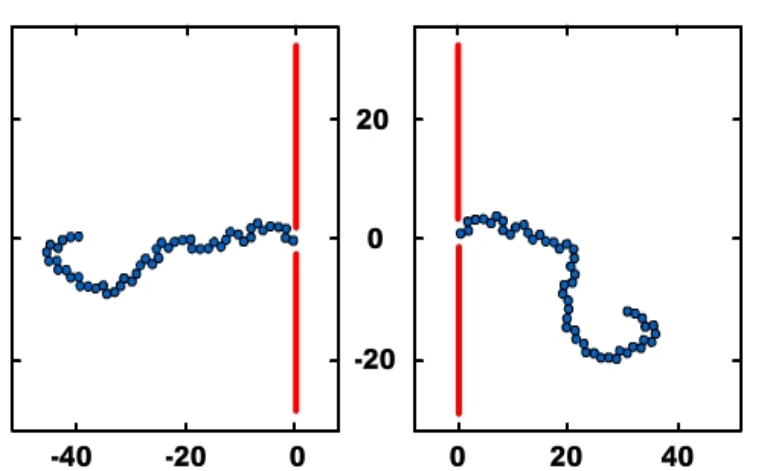
Figure 4. The polymer configurations of numerical computation, for N = 50. Initial position: polymer in cis zone ( left side ); final position: polymer in trans zone ( right side ).